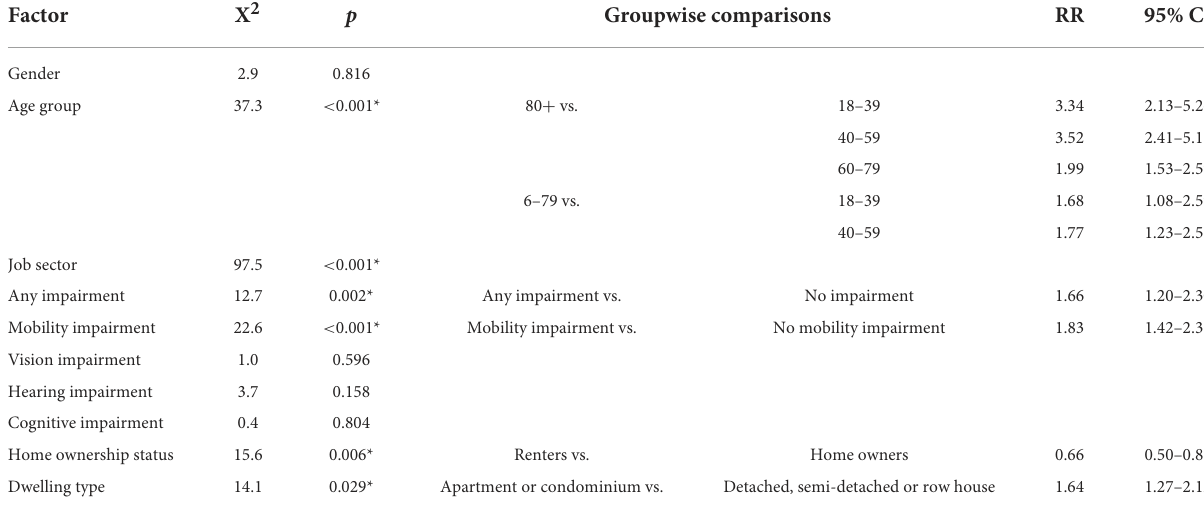
TABLE 3 Probability of currently having a grab bar (GB1): Comparison by respondent demographic characteristics, disability status and living environment. Factor X 2 p Groupwise comparisons RR